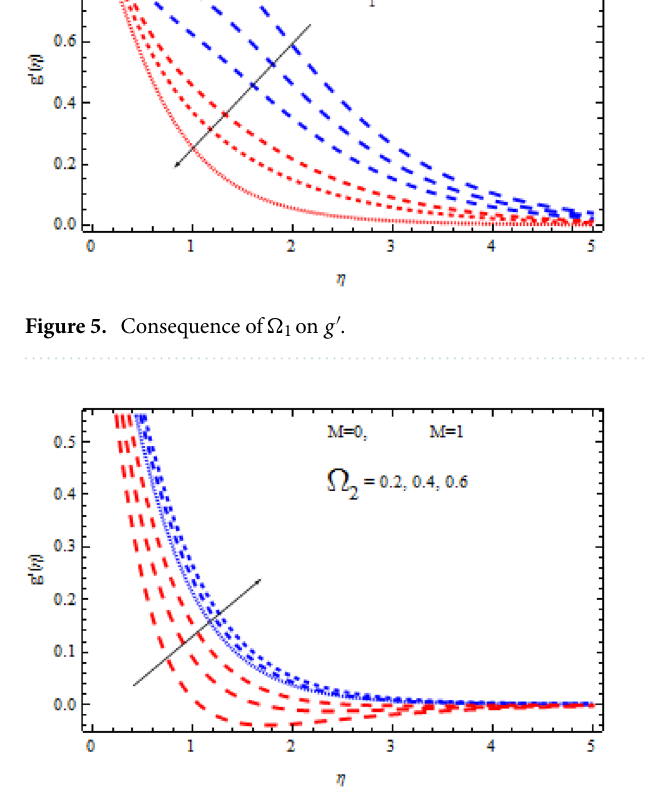
Figure 6. Consequence of (cid:31) 2 on f ′ .